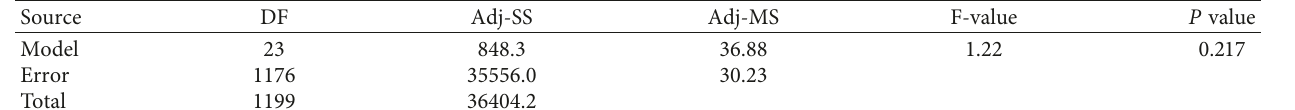
Table 10: Analysis of